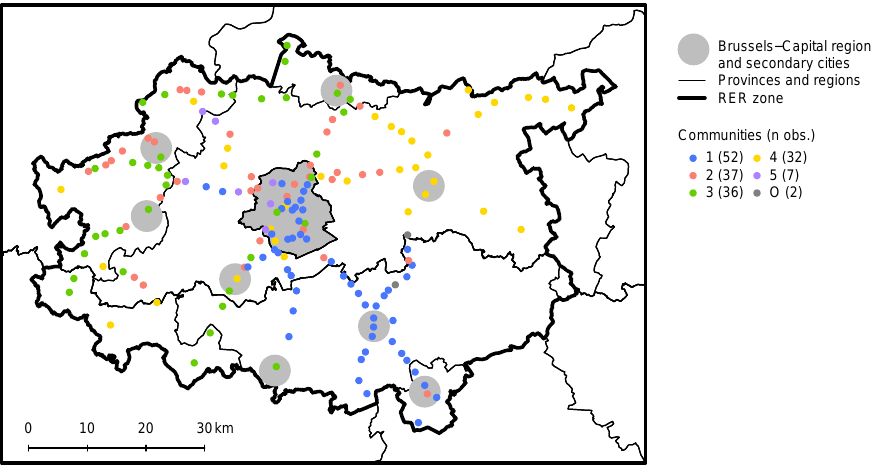
Figure 8. Communities detected within the RER zone (note: O = other communities, with less than five train